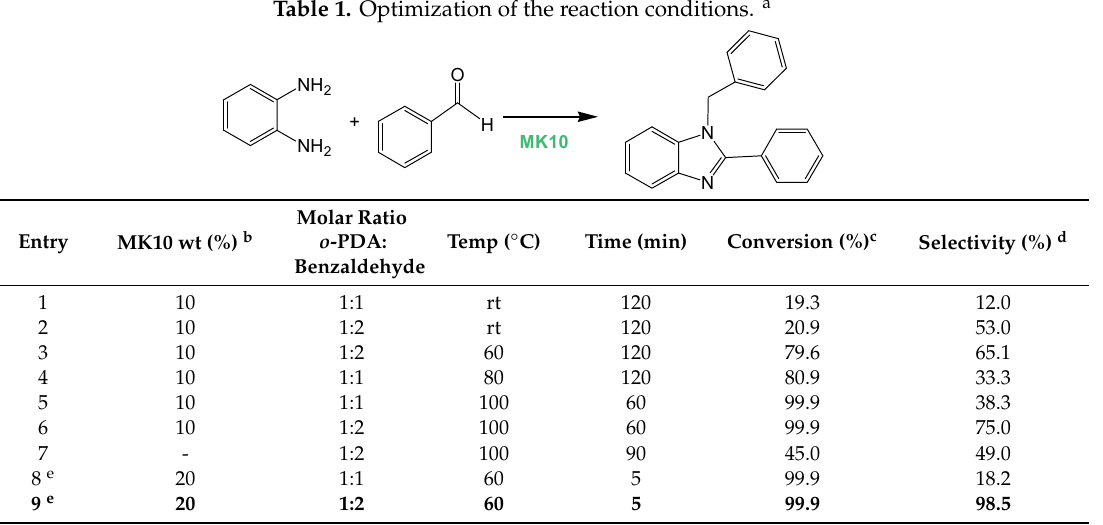
Table 1. Optimization of the reaction conditions. a